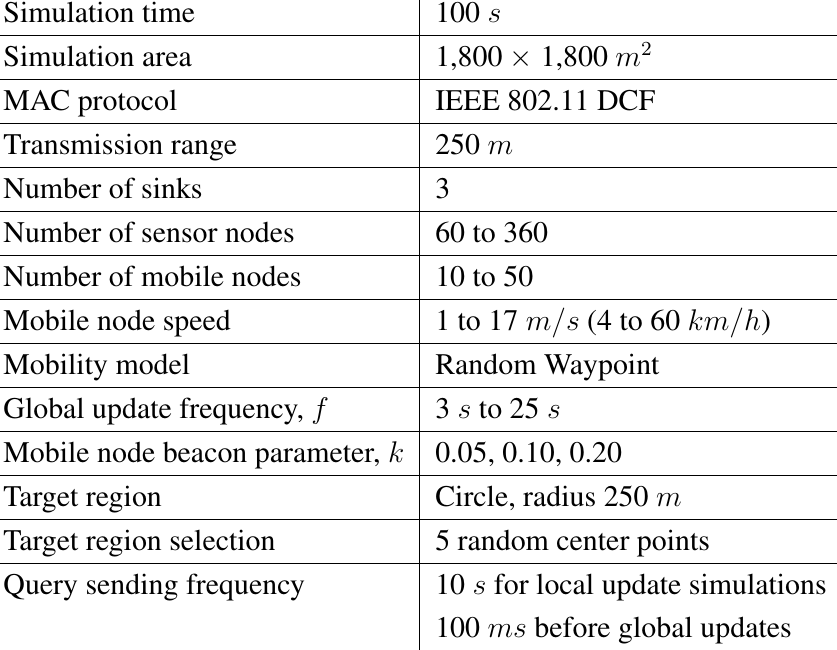
Table 1. Simulation